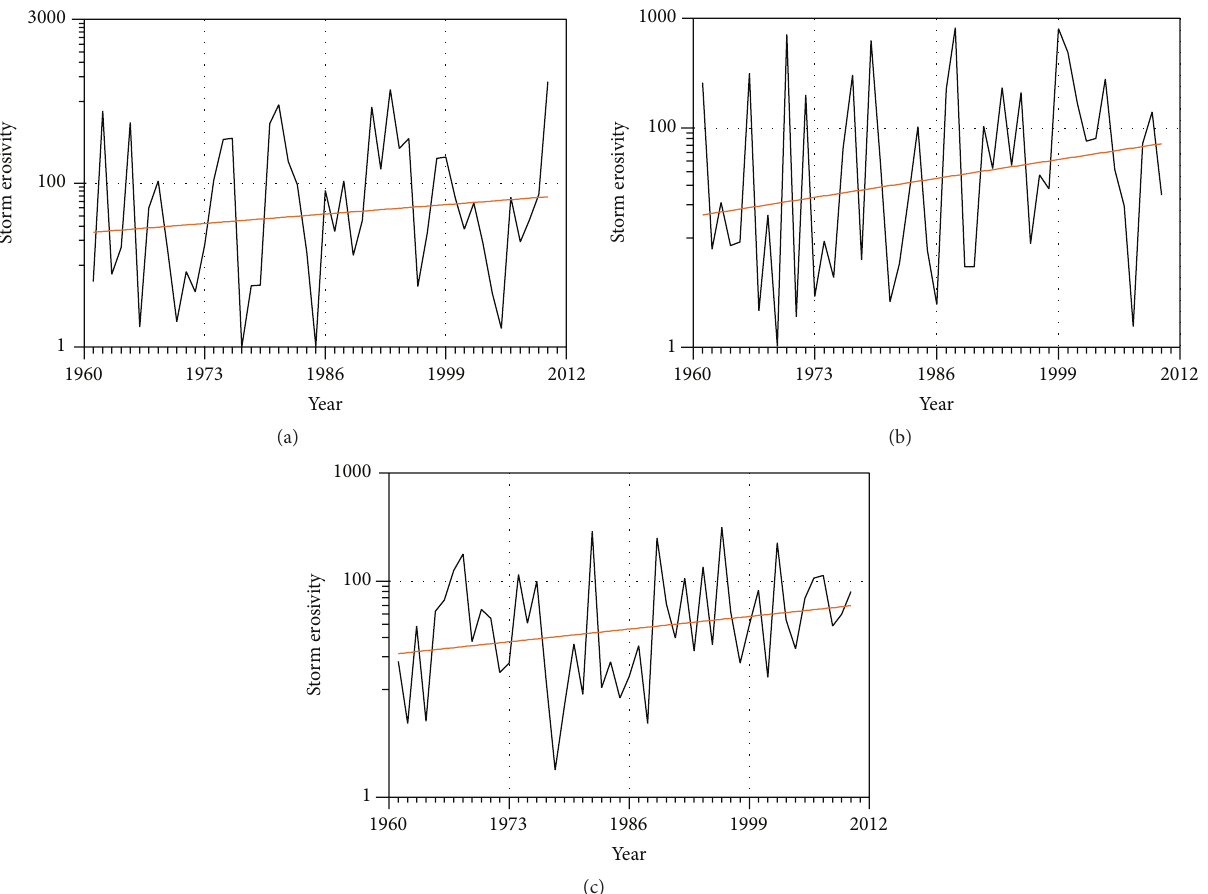
Figure 7: Temporal pattern of monthly storm erosivity at Lyon station for the months of September (a), October (b), and November (c) over the period 1961–2010, estimated with the model of Diodato [59]. Power trend with orange lines is also